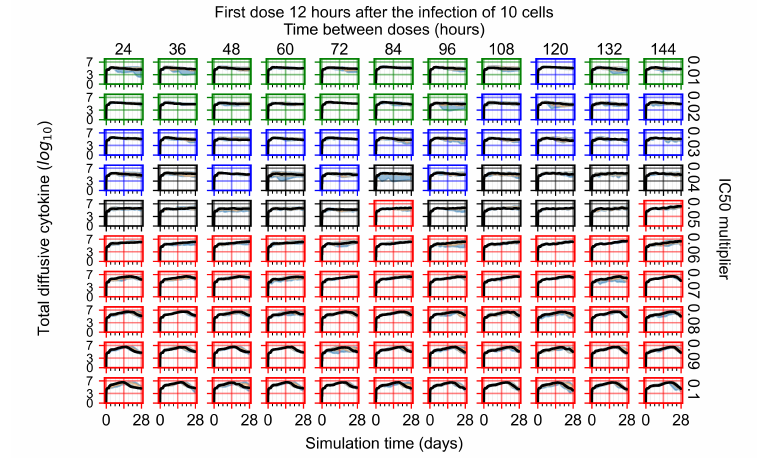
Figure A89. Diffusive cytokine amount for eight replicas of the treatment simulation, Y axis in log scale, and exponent values as tick marks.